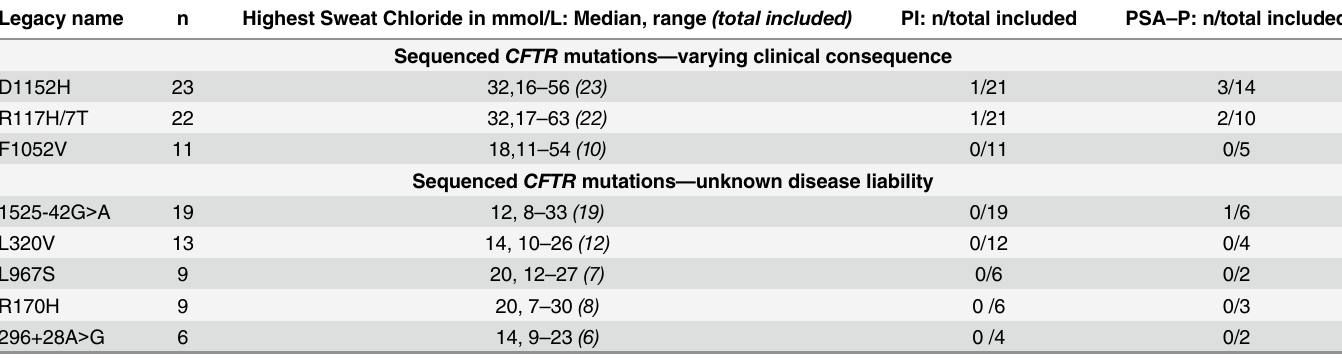
Table 3. Subjects with one CF-causing mutation from the California 40 panel plus a second mutation identified by sequencing and classified as varying clinical consequence or unknown disease liability, with frequency (cid:1)